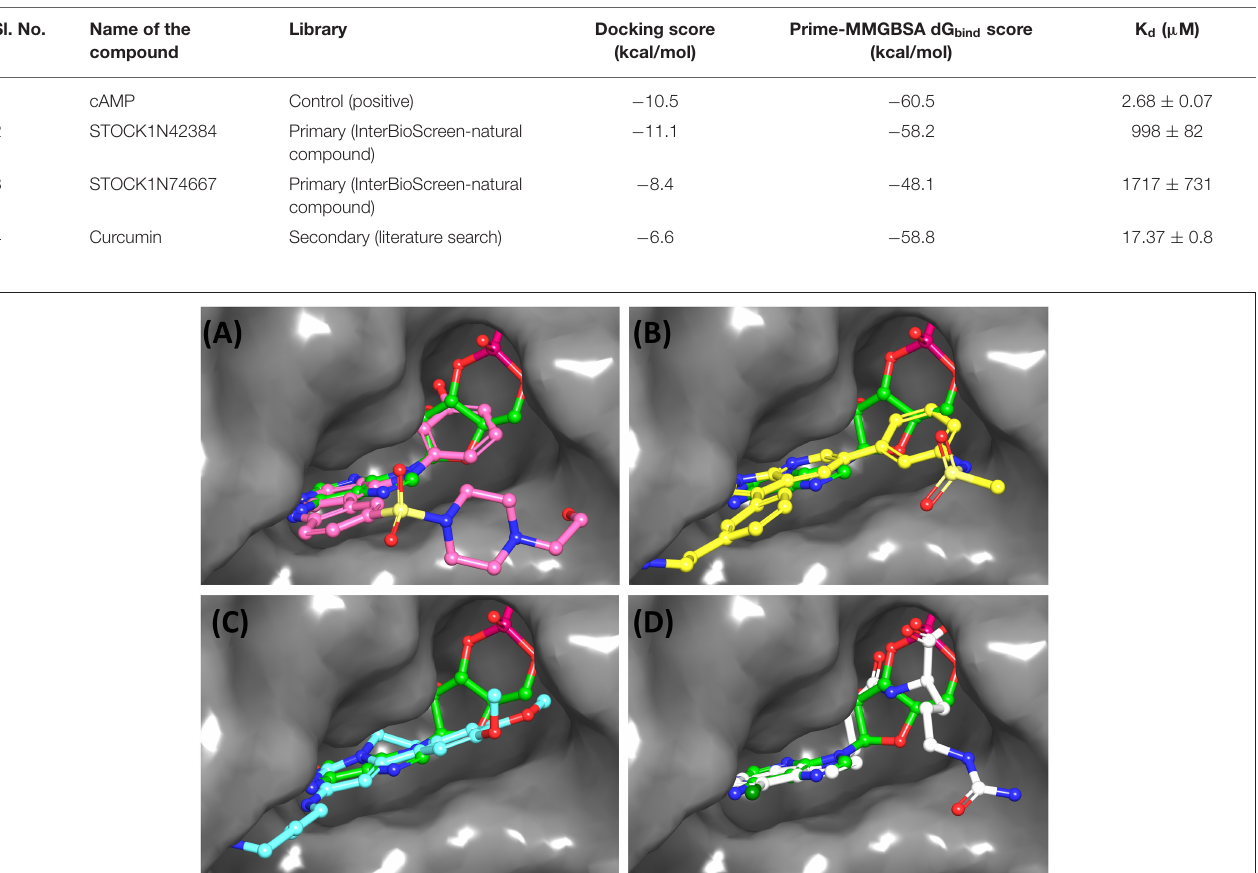
of two selected in silico hits from the ChEMBL library